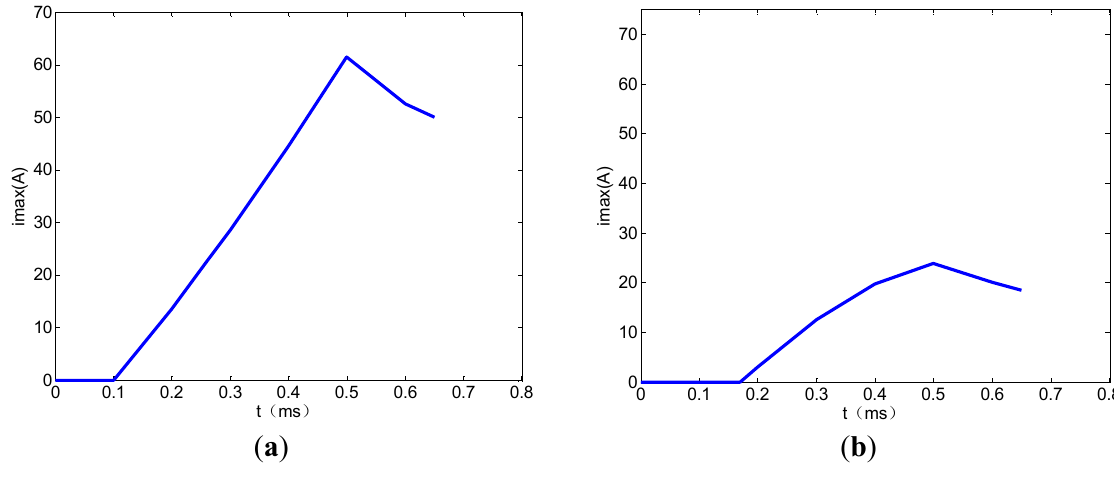
Figure 9. Curve of current vector. ( a ) Curve of d-axis current vector; and ( b ) curve of q-axis current vector.